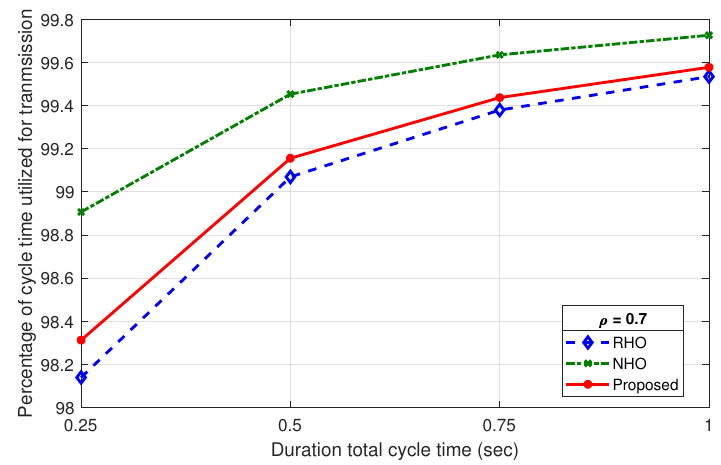
Figure 17. Percentage of cycle time utilization for data transmission against ρ =